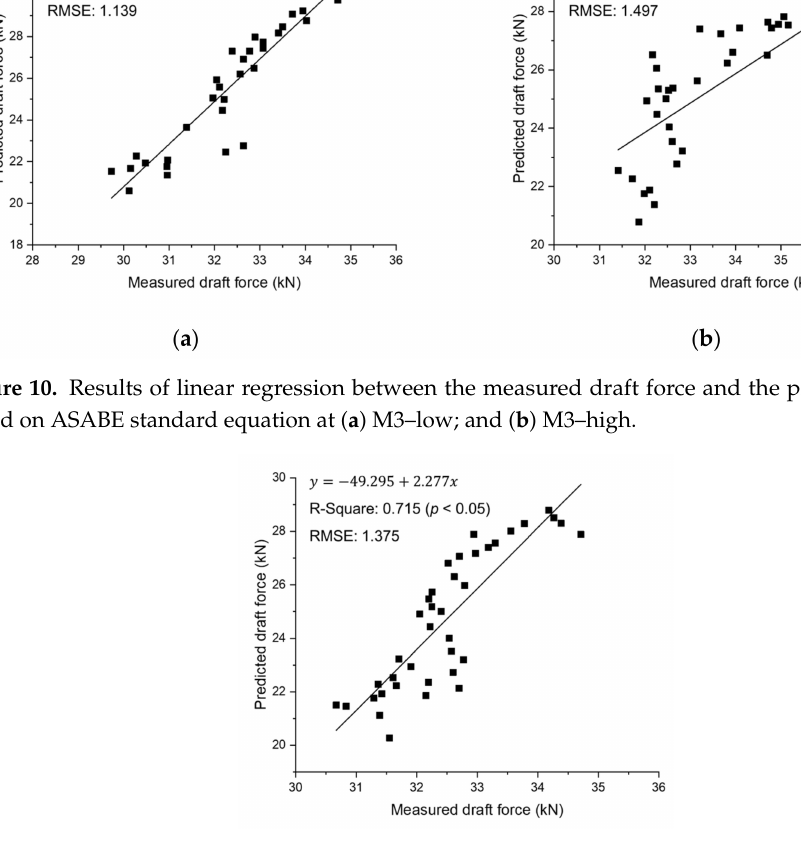
Figure 11. Results of linear regression between the measured draft force and the predicted values based on the ASABE standard equation using integrated data of two